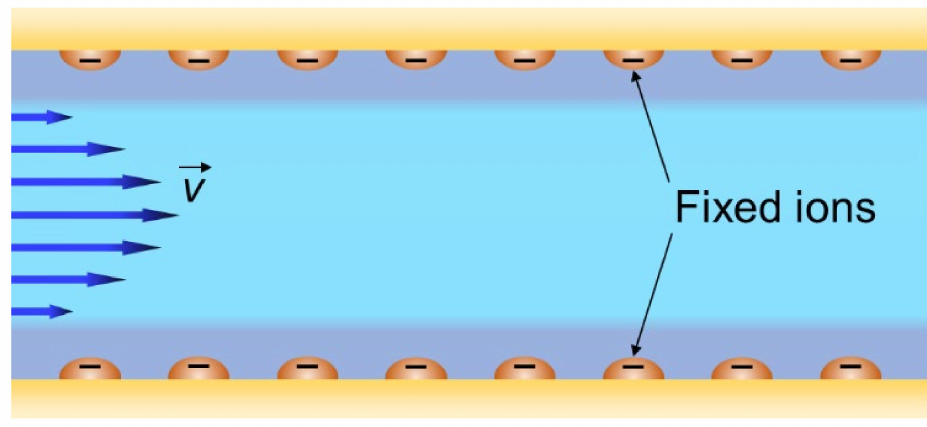
Figure 14. Schematic representation of solution flow in a tubular pore with charged walls; an EDL at the wall is shown in a darker shade. Redrawn from